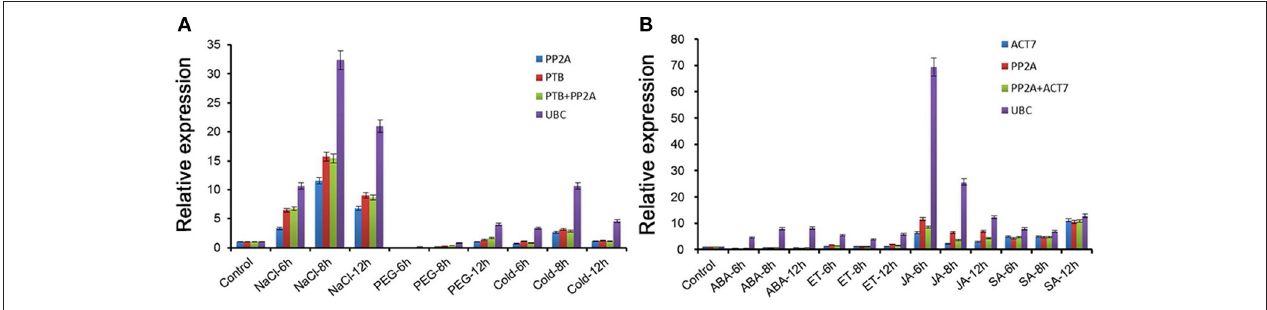
FIGURE 3 | Relative expression of HcWRKY28 using the selected reference genes. Results were normalized using the selected stable references (singly or in combination) and the unstable reference gene in sample sets across (A) abiotic stress-, and (B) hormonal stimuli-treated samples at 0, 6, 8, 12 h. Bar indicates the standard error ( ± SE) evaluated from three biological